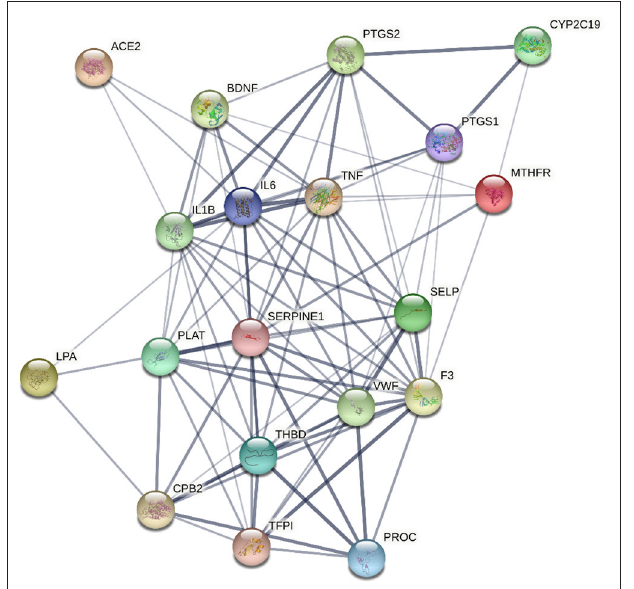
FIGURE 4 | Network, constructed by the STRING protein-protein interaction network tool, of the 18 genes targeted by miRNAs associated with Brain-Derived Neurotrophic Factor and related to thrombosis, atherosclerosis, atherothrombosis, and cardiovascular disease. The line thickness represents strength of the interaction.